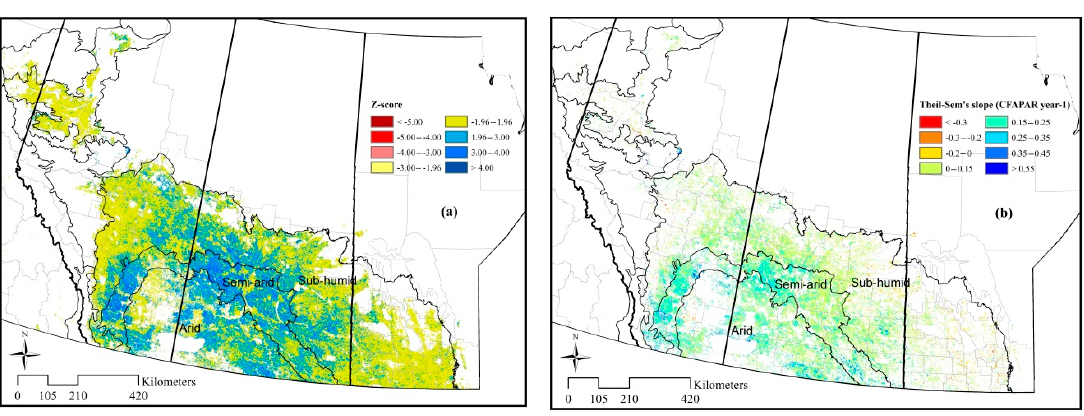
Figure 6. Spatial patterns of crop productivity trends from 2000 to 2013 using MK method; Mann–Kendall Z -score ( a ) and the Theil-Sen median slope of the trend in CFAPAR significant at p < 0.05 ( b ).